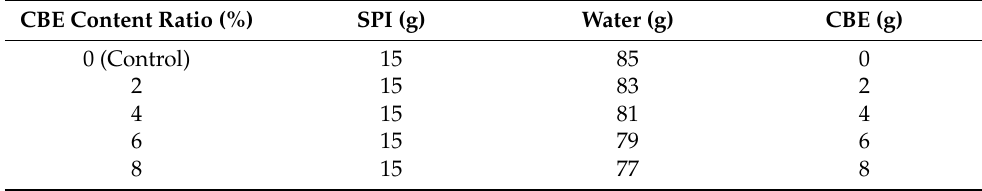
Table 1. Formulations of the adhesives with different CBE content. CBE Content Ratio (%) SPI (g) Water (g) CBE